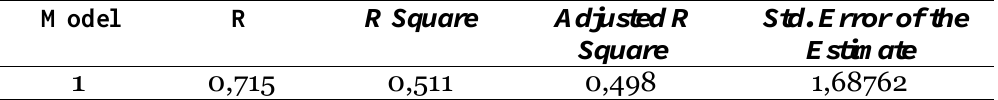
Determination Coefficient